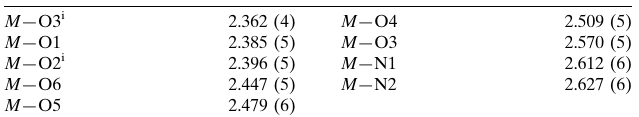
Selected bond lengths (A˚ ). M denotes Eu or Sm.